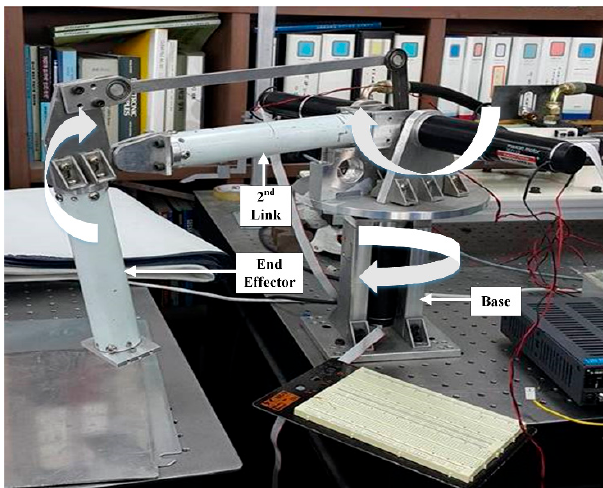
Figure 6. Master device.